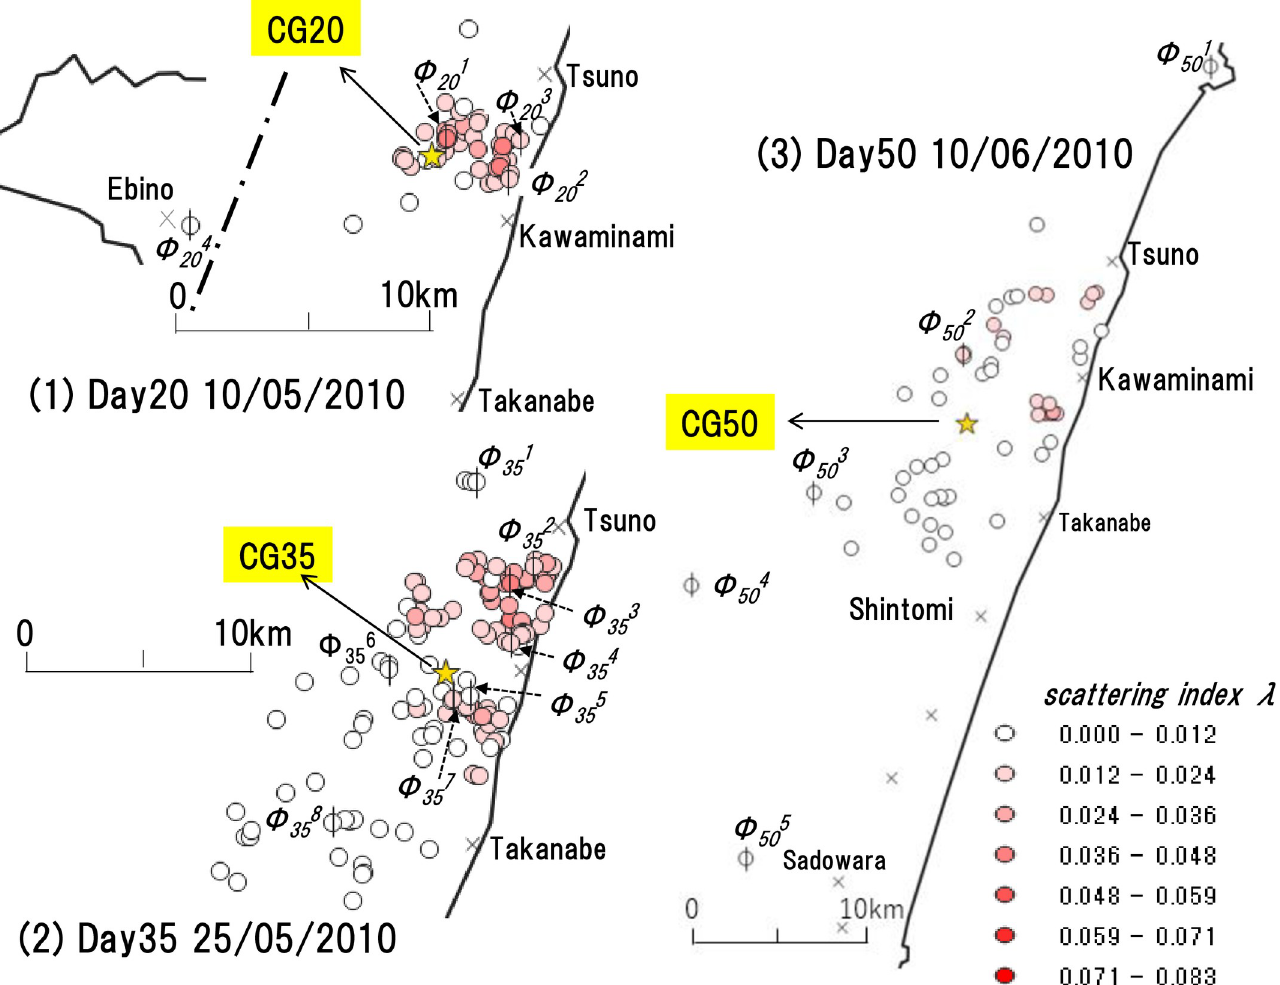
Fig 5. Distance from the center of gravity of the entire infected farm. (1), (2), (3) represents the infection situation on the 20th (10/05/2010), 35th (25/05/2010), 50th (10/06/2010) day after the outbreak. In each case, the circles show the infected farms. Circles with vertical lines show the farms confirmed infected on that day. The color gradation of each farm (circle) represents the indensity of the scattering index λ of the day of interest. Asterisks (CG20, CG35, and CG50) show the center of gravity (referred to as the "center of gravity") of the entire infected farm (circle) on each day. For example, the circle in (1) represents the farm infected 20 days after the outbreak, and the asterisk CG20 represents the "center of gravity" of the entire farm. The farms confirmed infected on this day (Day 20) are the four circles with vertical lines, and the indexes F 201 , F 202 , F 203 , and F 204 ,